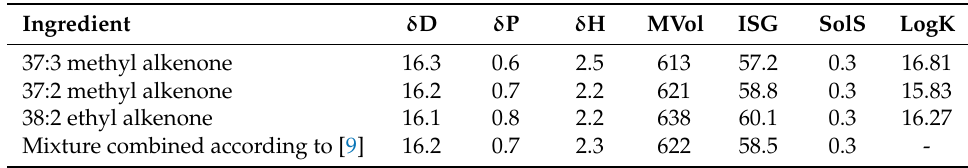
Table 4. Parameters calculated by Formulating for Efficacy TM